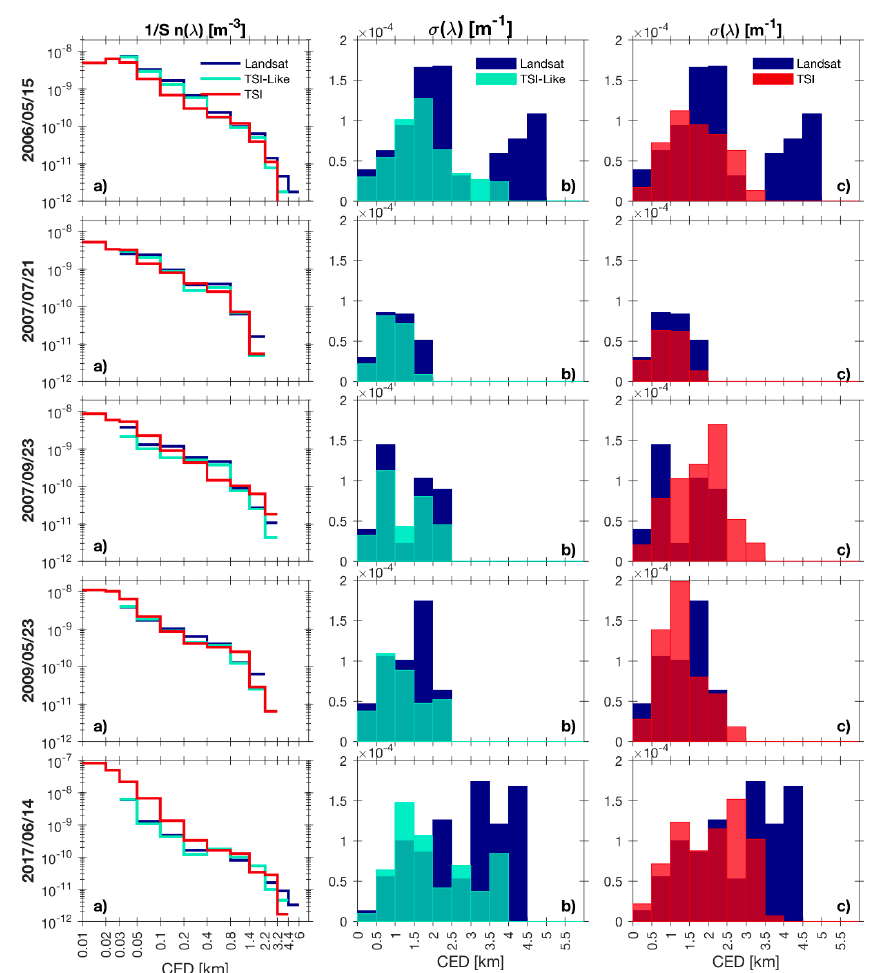
Figure 6. Distributions of CED from Landsat (navy), TSI (red) and TSI-like simulator (green) for 5 days. ( a ) subfigures of normalized cloud size distribution (Equation (2)). ( b , c ) cloud cover density (Equation (3)) compared for ( b ) TSI-like (turquoise) and Landsat (navy) and ( c ) TSI (red) and Landsat (navy). Note that Landsat cloud areas extend beyond the observed area S as shown in Figure 4. The median L 50 and other percentiles of the cloud cover density σ ( λ ) (Equation (3)) illustrate differences in CED obtained from these three approaches (Figure 5b). The three approaches TSI, TSI- like and Landsat show mutual agreement when there is a high-quality TSI mask and Landsat L 50 is